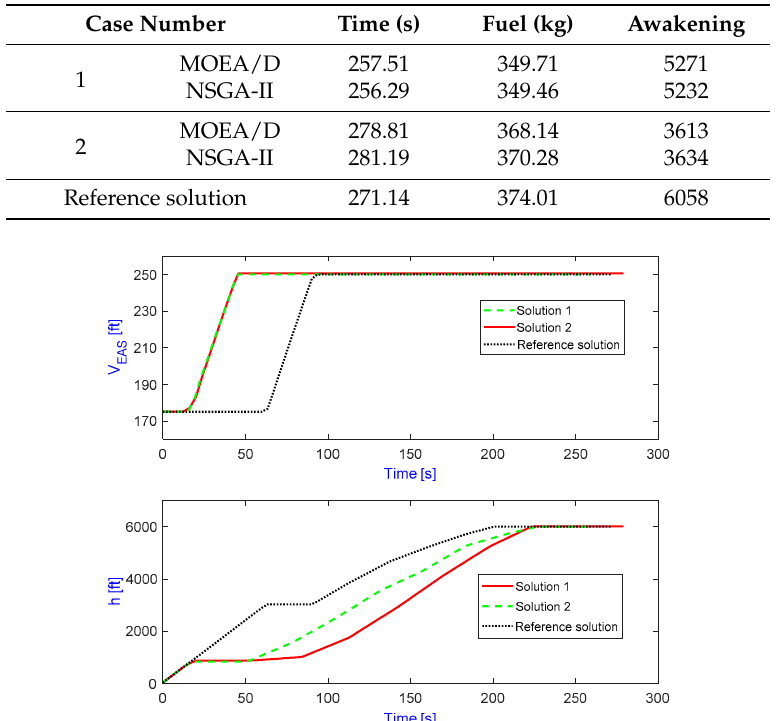
Table 2. Comparison of objectives of cases 1–2 and the reference case.